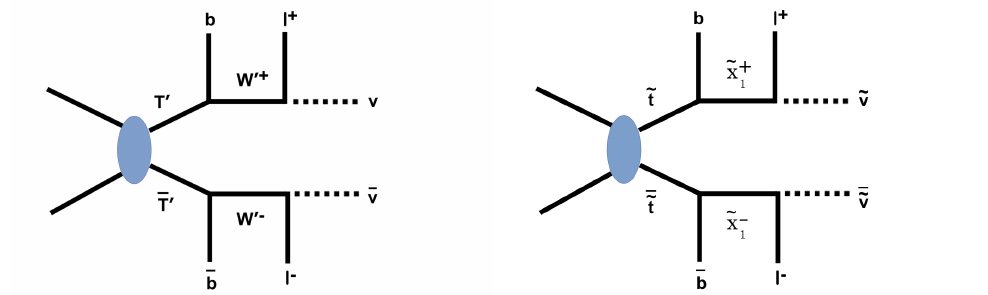
Figure 6 . A topology for anything decaying like dilepton top pairs with both a new heavy top partner T 0 and a new heavy gauge boson W 0 (left) as well as a pair produced stop quark topology with similar final state